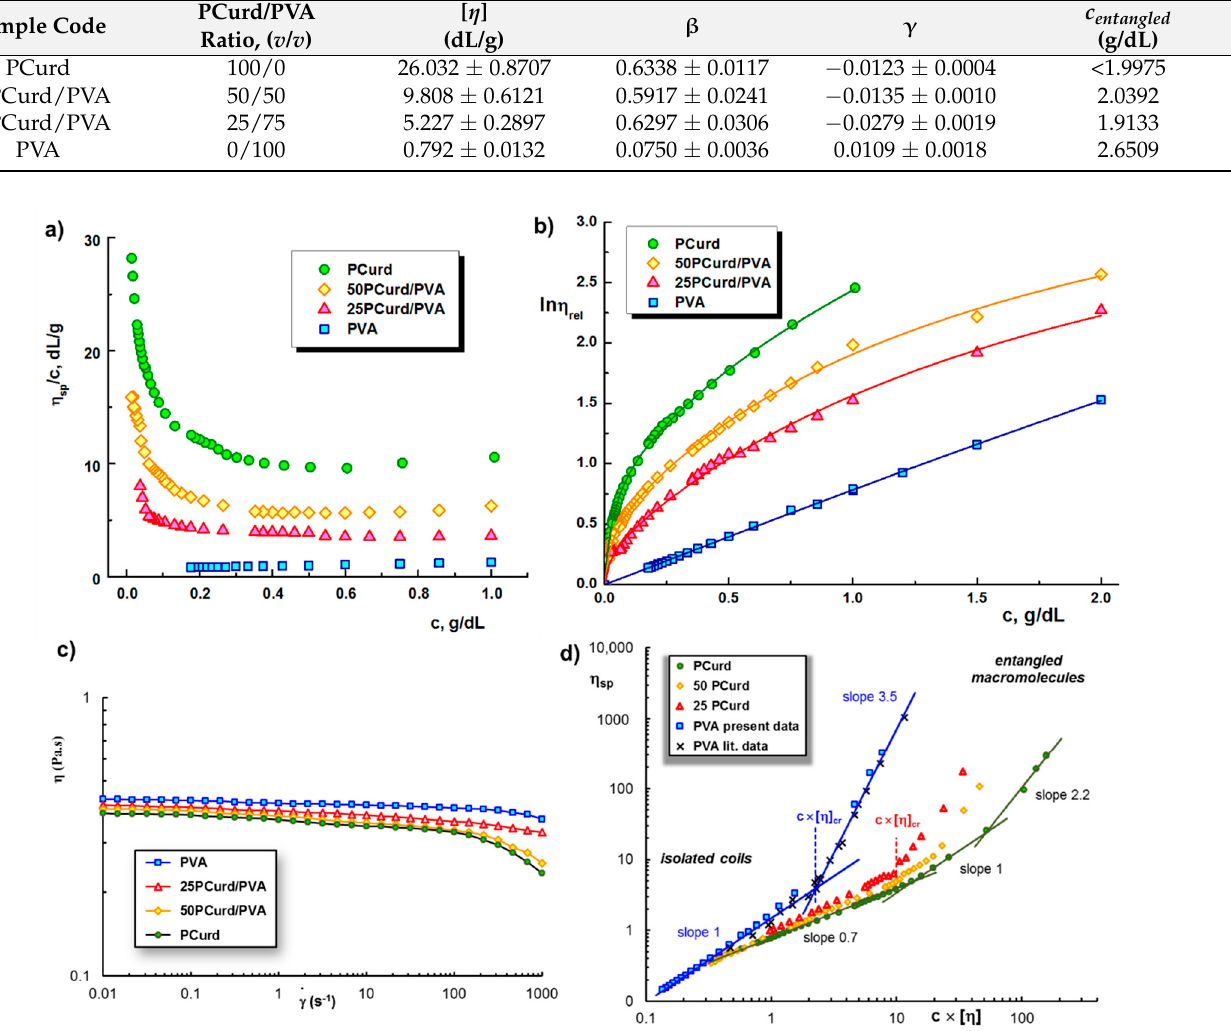
Figure 1. ( a ) Dependence of reduced viscosity and ( b ) natural logarithm of the relative viscosity as function of polymer concentration for PCurd, PVA, and PCurd/PVA mixture in pure water at 25 °C; ( c ) Shear viscosity as a function of shear rate for PVA, PCurd, and PVA/PCurd mixtures at 25 ° C; ( d ) Specific viscosity as a function of c × [ η ] for PVA, PCurd, and PVA/PCurd mixtures in aqueous solution at 25 °C. Other reported data for PVA were included [46].